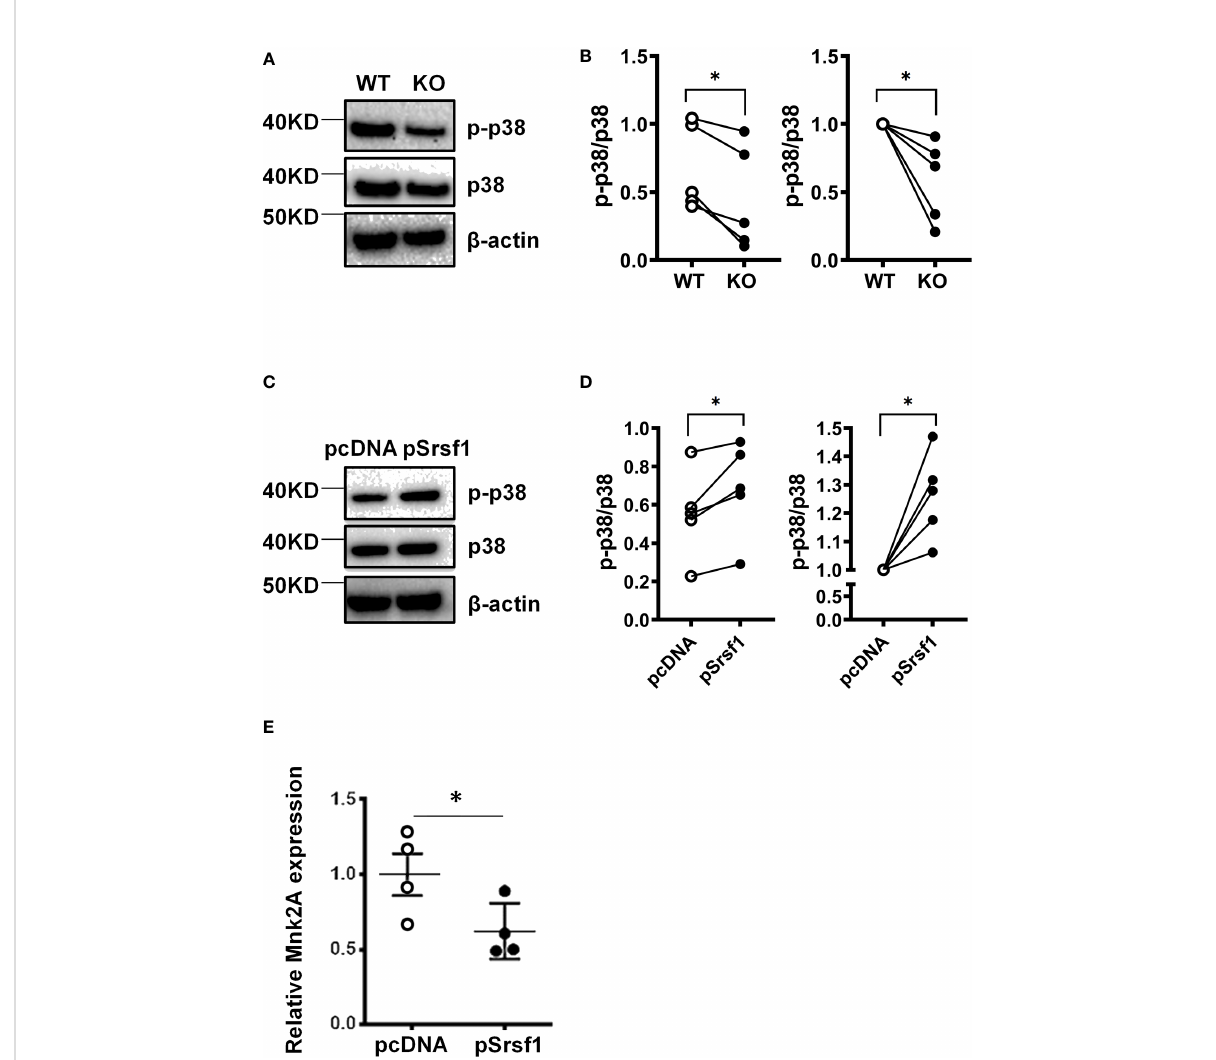
FIGURE 6 SRSF1 controls Mnk2 expression and activity of the p38 MAPK pathway. (A) Total mouse T cells were isolated from spleens of WT and Srsf1 -cKO mice and stimulated with anti-CD3 and anti-CD28. Total protein was immunoblotted for phospho-p38 (p-p38), p38, and b -actin. Image showing one representative blot from 5 independent experiments. (B) Graph shows relative quantitation by densitometry. (C) Peripheral blood T cells were isolated from healthy donors and transfected with empty vector (pCDNA) or Srsf1 overexpression plasmid (pSrsf1). Transfected T cells were stimulated with anti-CD3 and anti-CD28. Total protein was immunoblotted for phospho-p38 (p-p38), p38, and b -actin. Image showing one representative blot from 5 independent experiments. (D) Graph shows relative quantitation by densitometry. (E) Relative mRNA expression of Mnk2a isoform in human T cells. Graphs show mean ± SEM, p-values